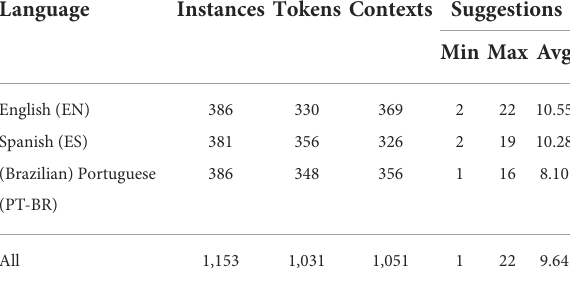
TABLE 2 Statistics on the TSAR-ST 2022 Lexical Simplification